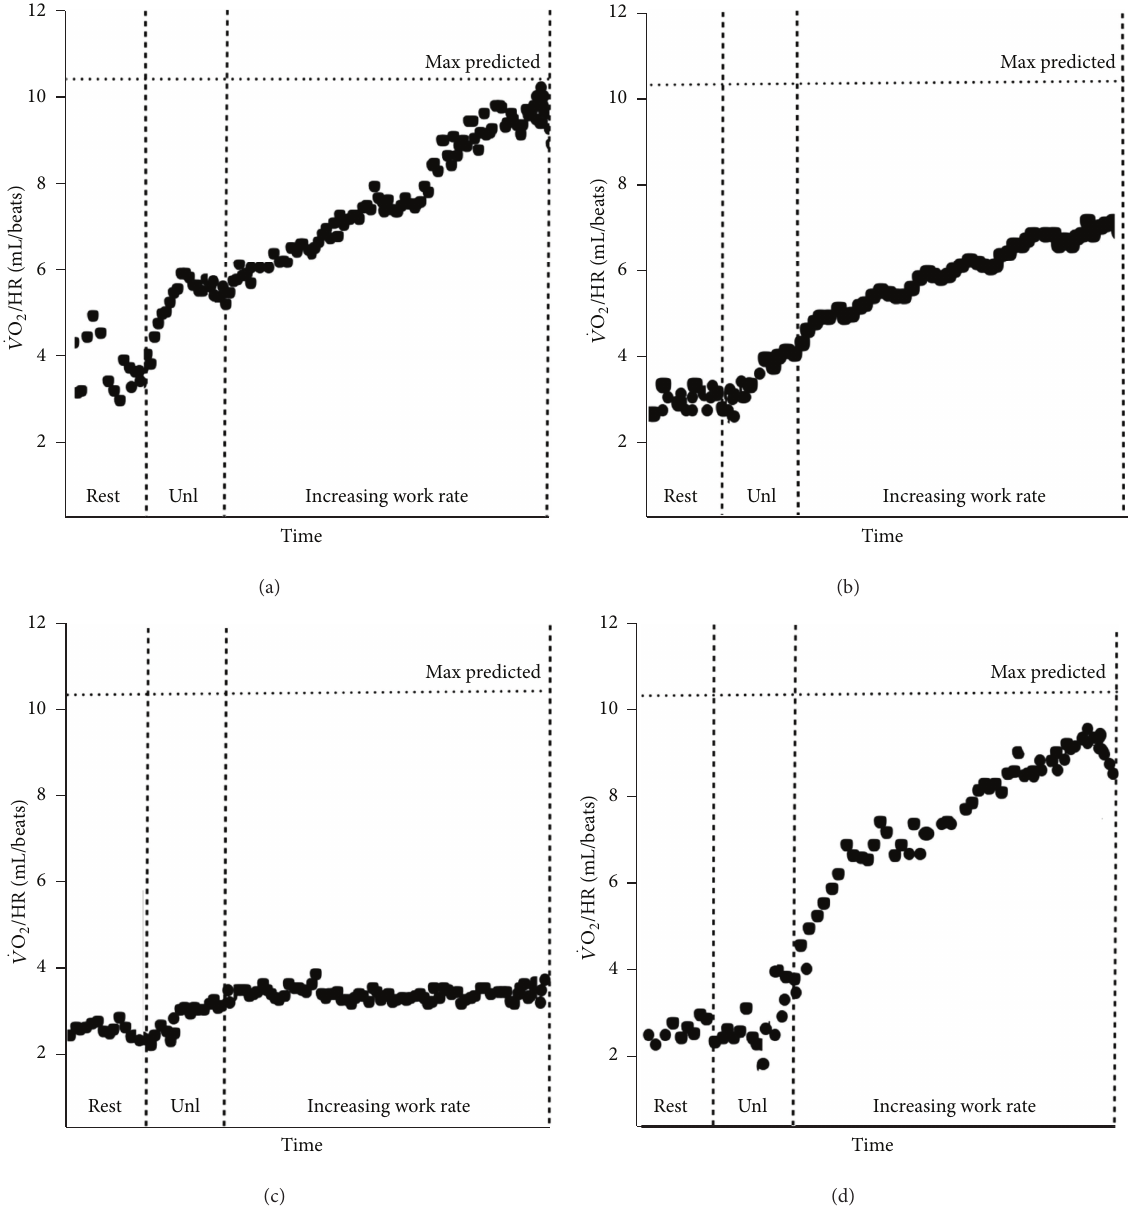
̇𝑉 / HR ) as a function of time during incremental exercise. (a) Curvilinear increase up to a normal predicted value in a Figure 13: O 2 pulse ( O 2 healthy subject; (b) abnormally low peak values due to ventilatory limitation and early exercise cessation in a patient wirh COPD; (c) failure to increase and early plateau in a patient with end-stage pulmonary arterial hypertension; (d) decrease at near maximum exercise in a patients with concomitant electrocardiographic abnormalities indicative of coronary artery disease. Unl is unloaded